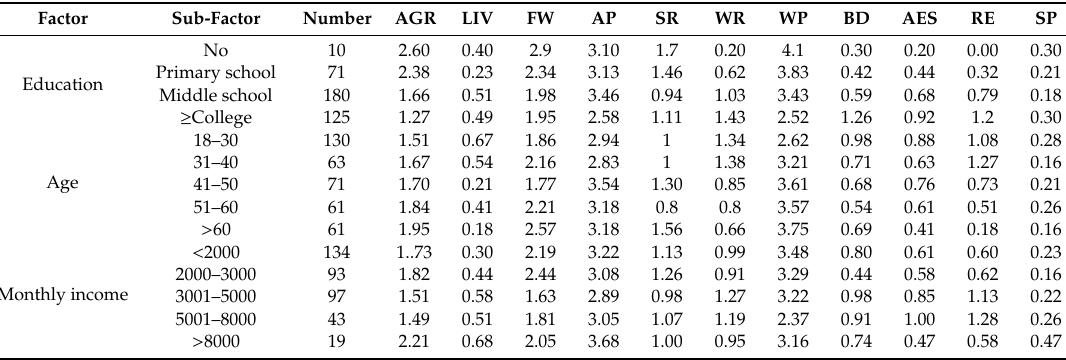
Table A3. Mean value of each group of personal